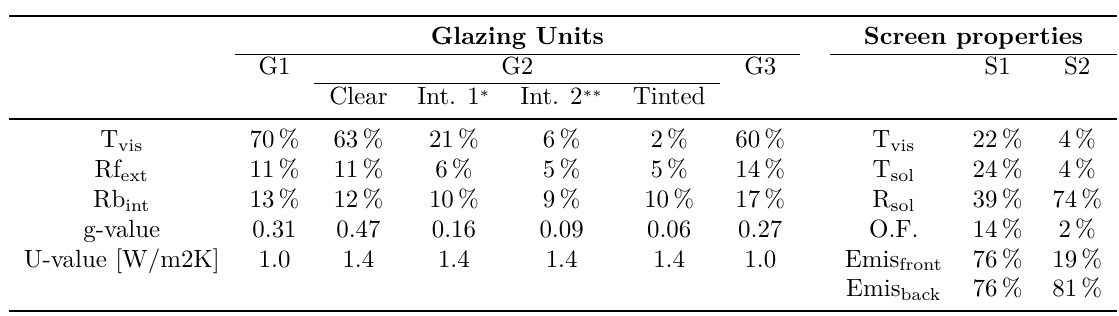
Table 1. Solar control glasses performances and Screen fabric